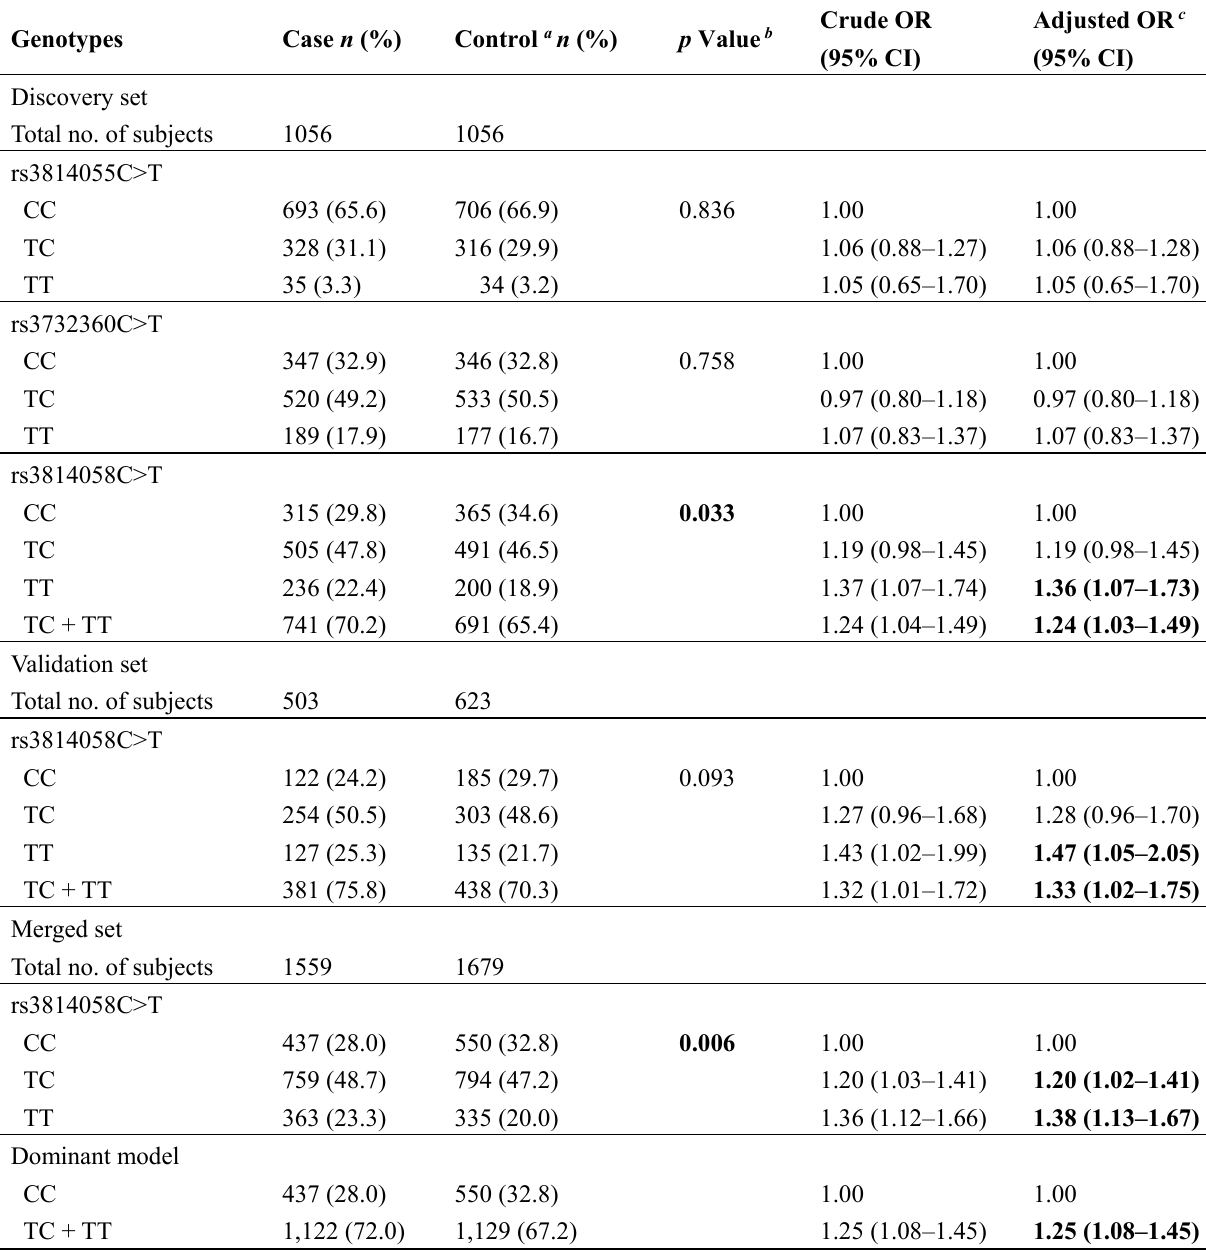
Table 1. Frequency distributions of genotypes of pregnane X receptor ( PXR ) single nucleotide polymorphisms (SNPs) and their associations with the risk of lung